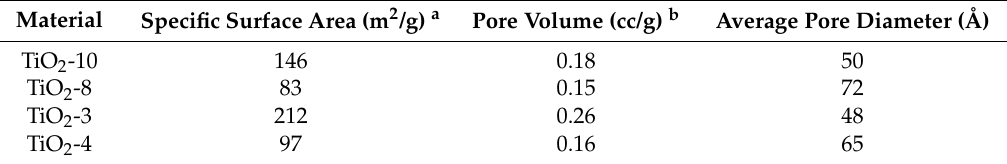
Figure 3. Nitrogen physisorption isotherms and Pore Size Distributions (insets) of hard templated mesoporous TiO 2 ( A ) TiO 2 -10; ( B ) TiO 2 -8; ( C ) TiO 2 -3; and ( D ) TiO 2 -4 as function of cycles and titanium precursor. Table 2. Physico-chemical properties of mesoporous hard template TiO 2 .